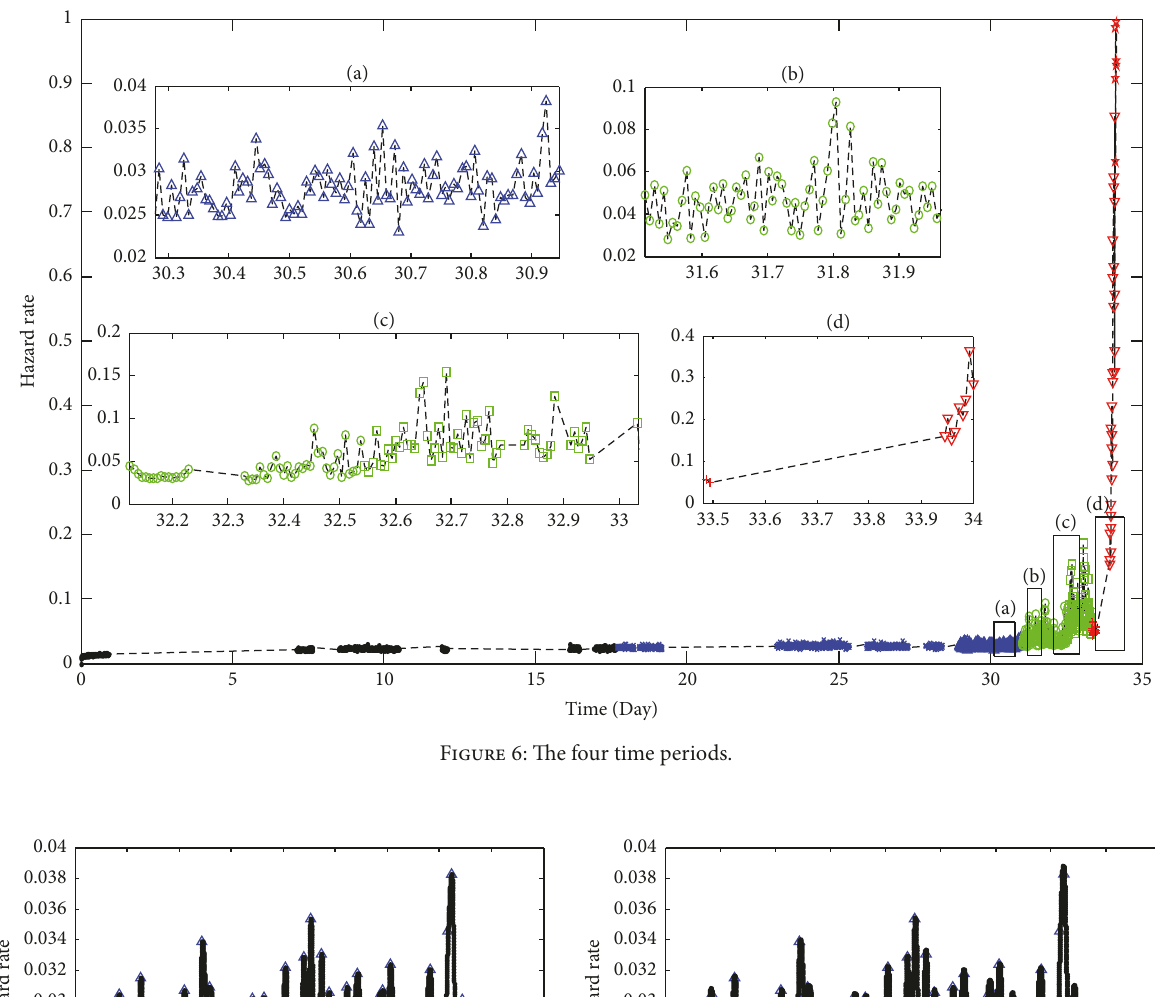
Figure 6: The four time periods.